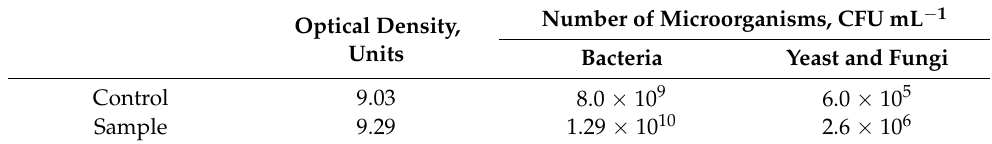
Table 2. Study of the effect of the extractant on soil microflora.